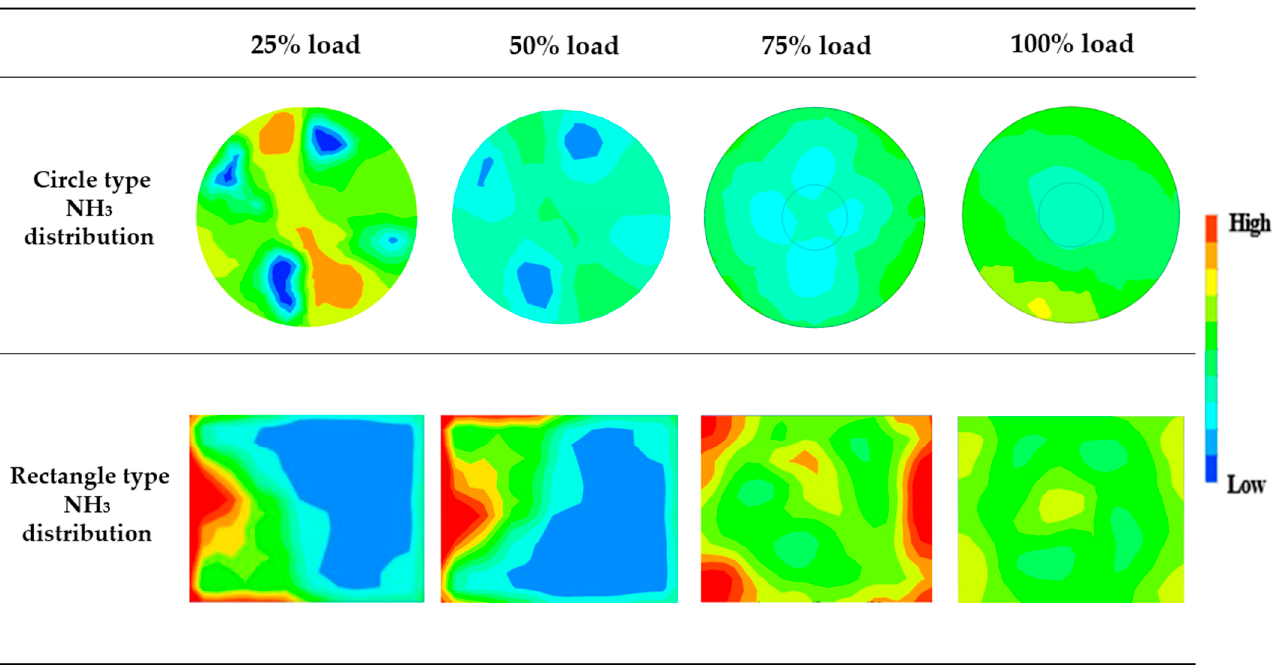
Figure 5. NH 3 distribution with engine load conditions.